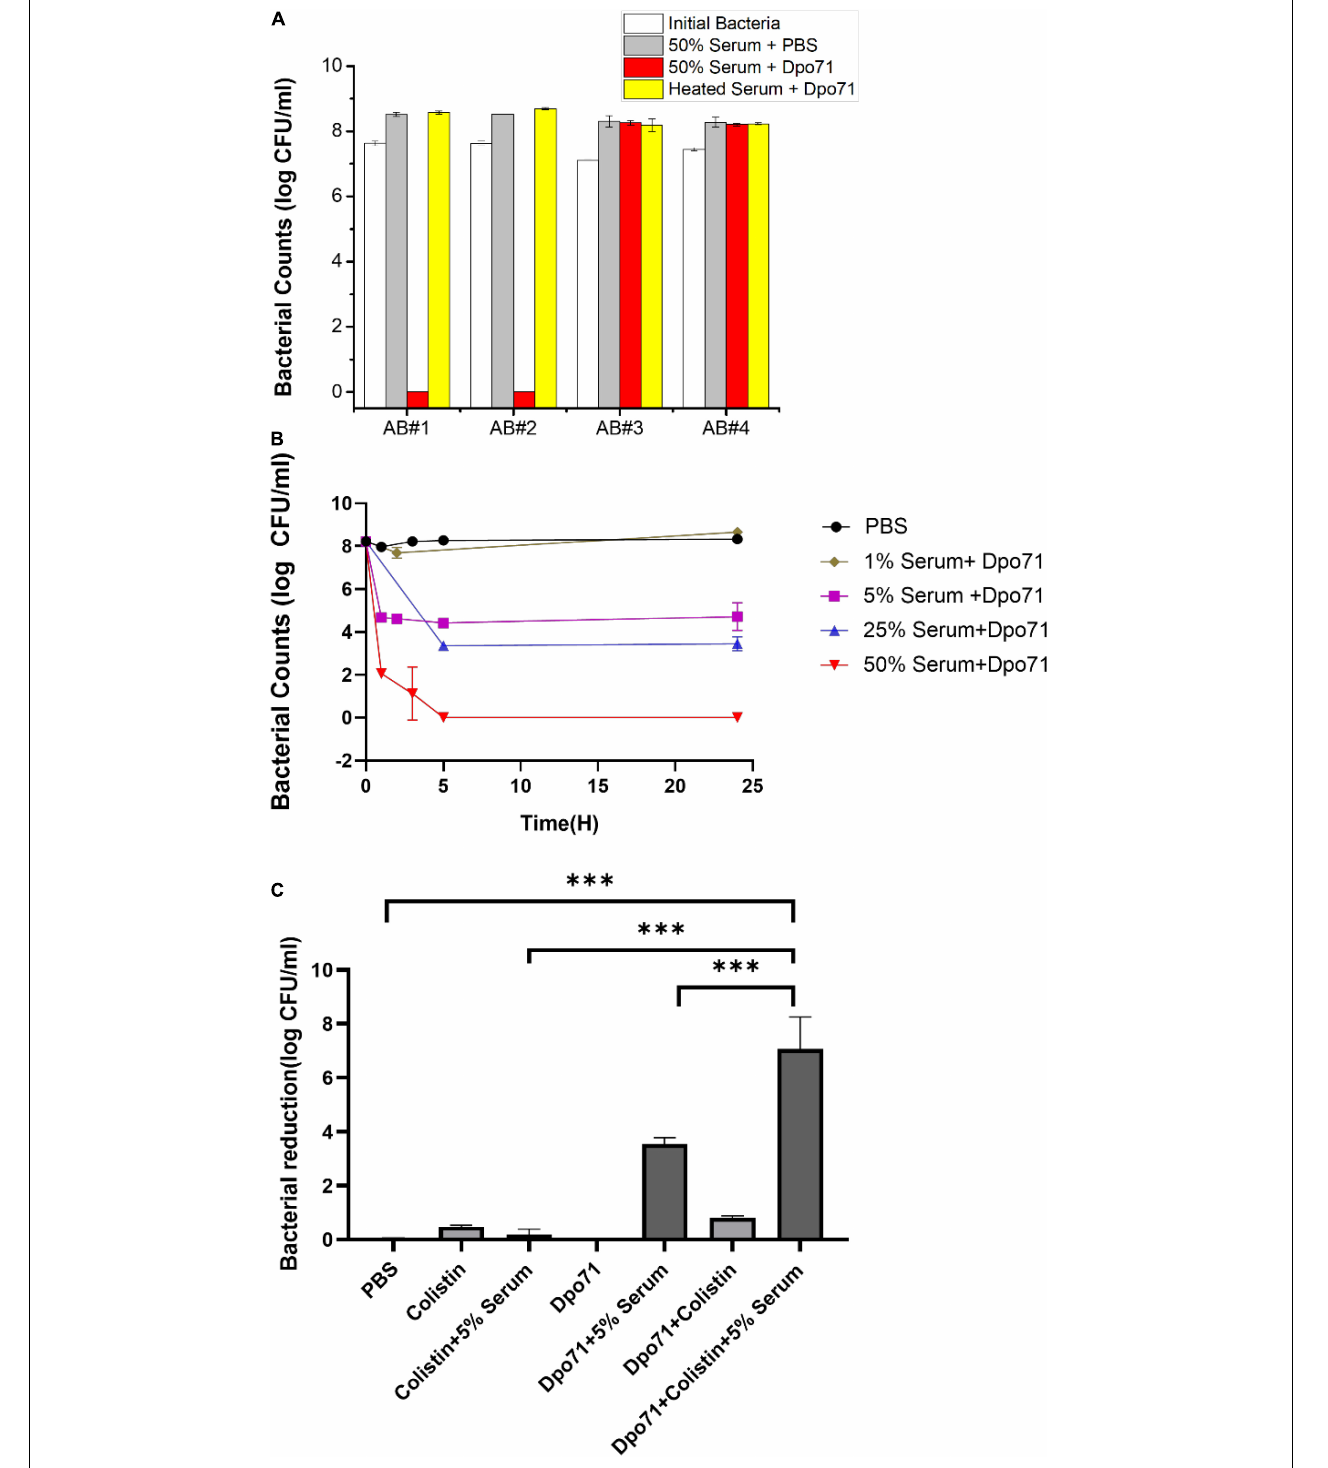
FIGURE 3 | Dpo71 enhanced the serum sensitivity and colistin activity against A. baumannii. (A) Bacterial susceptibility to the treatment with Dpo71 concentration of 10 µ g/ml and 50% serum volume ratio. A. baumannii clinical strains sensitive (AB#1 and AB#2) and insensitive (AB#3 and AB#4) to the phage IME-AB2 were tested. (B) Time-killing curve of Dpo71 (10 µ g/ml) against MDR-AB2 (AB#2 strain) in the presence of 1–50% human serum. (C) Dpo71 and colistin activity against A. baumannii in the presence/absence of 5% human serum. Data are expressed as means ± SD ( n = 3). ∗∗∗ indicates P < 0.001, Student’s t -test.